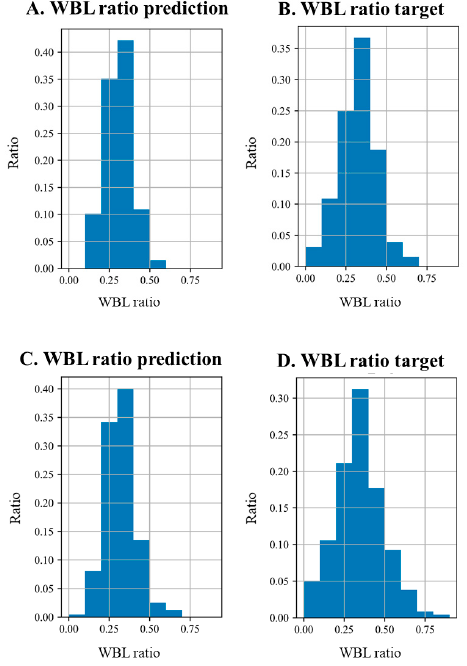
Figure 4. Histogram of the WBL ratio distribution in the validation and test sets. ( A – D ) Prediction distribution vs. target distribution. ( A ) WBL ratio prediction distribution in the validation set, ( B ) WBL ratio target distribution in the validation set, ( C ) WBL ratio prediction distribution in the test set, ( D ) WBL ratio target distribution in the test set. WBL ratio prediction: predicted value of the WBL, WBL ratio target: calculated WBL